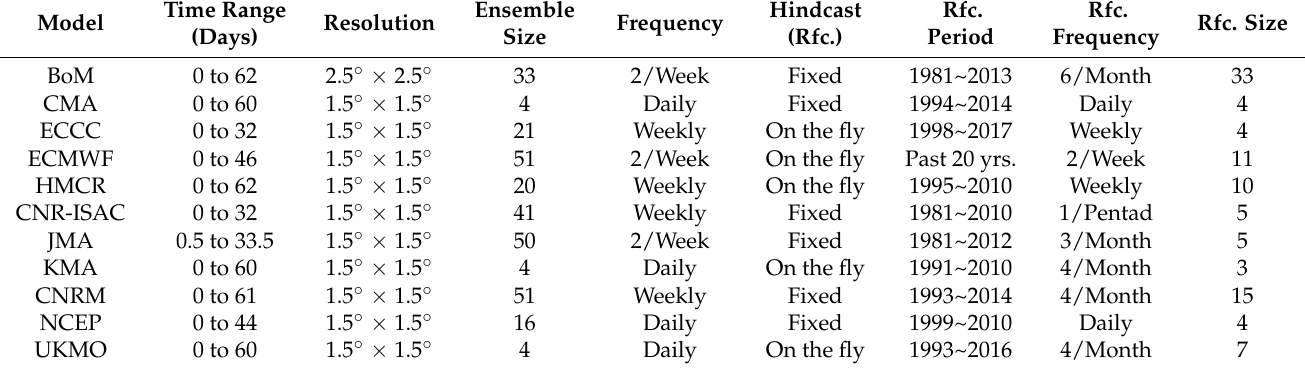
Table 1. The detailed information about the three S2S models (updated from Vitart et al. [19] according to ECMWF website), where “Time Range” is the forecast lead time, “Ensemble Size” is the number of members in the real-time forecast ensemble, and “Frequency” is the frequency the model is run. “Hindcast” or (reforecast, abbreviated as “Rfc.”) are run using the actual forecast model but for the past several years on the same (or nearby) calendar day as the forecast. The “Rfc. Period” is the number of years the reforecasts are run, “Rfc. Frequency” is the frequency the reforecasts are run, and the “Rfc Size” is the number of ensemble members for reforecasts. “Resolution” is longitude and latitude based on the data accessed from the ECMWF website.